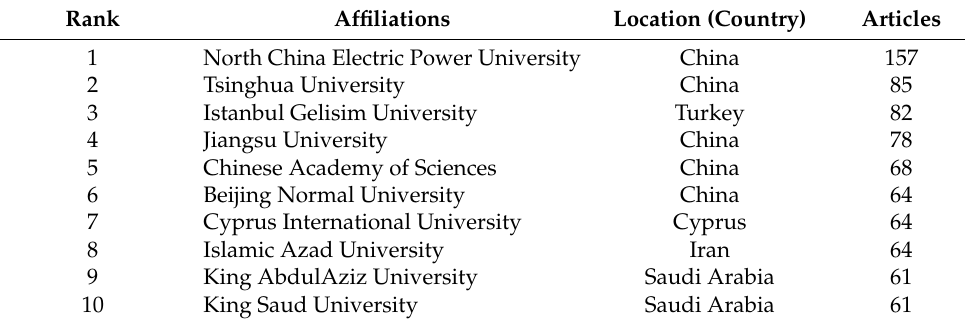
Table 7. Ranking of the top 10 most relevant